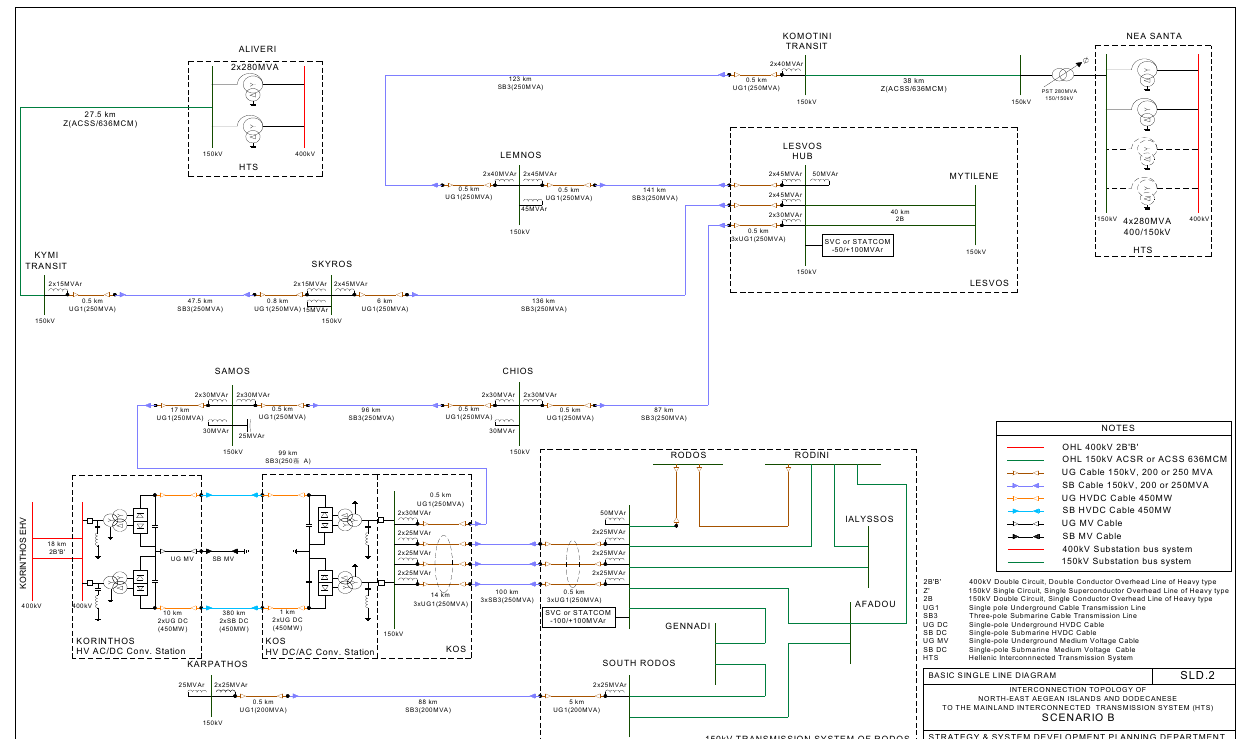
Figure 3. Single line diagram of the Scenario A (HVAC interconnection topology).